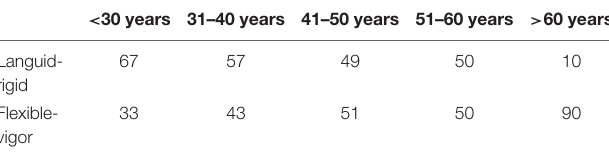
TABLE 3 | Percentage* of languid-rigid ( n = 135) and flexible-vigor ( n = 140) types by age categories.